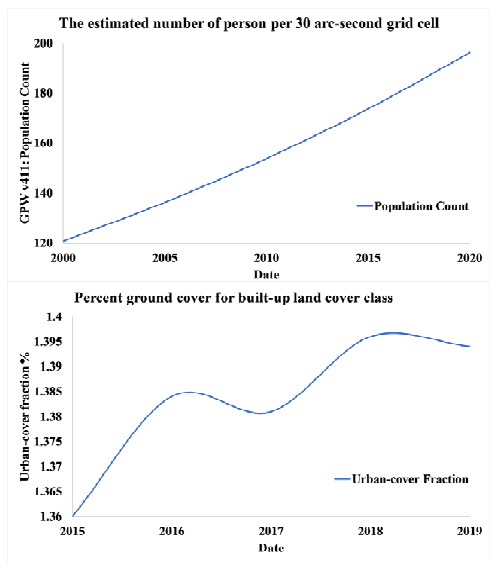
Figure 9. Mean population count and built-up area value per pixel.